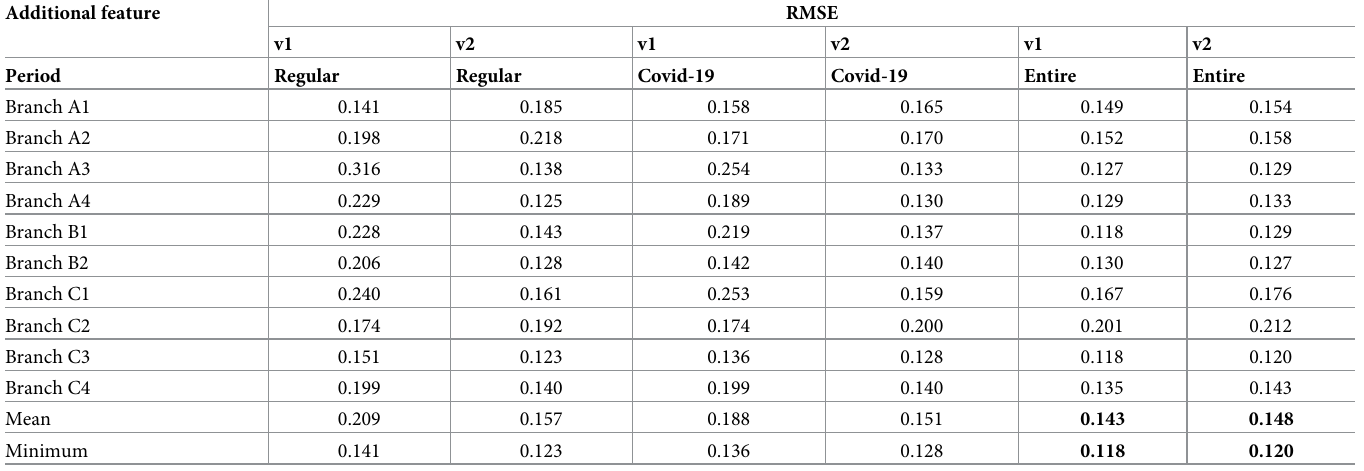
Table 4. RMSE values of CO